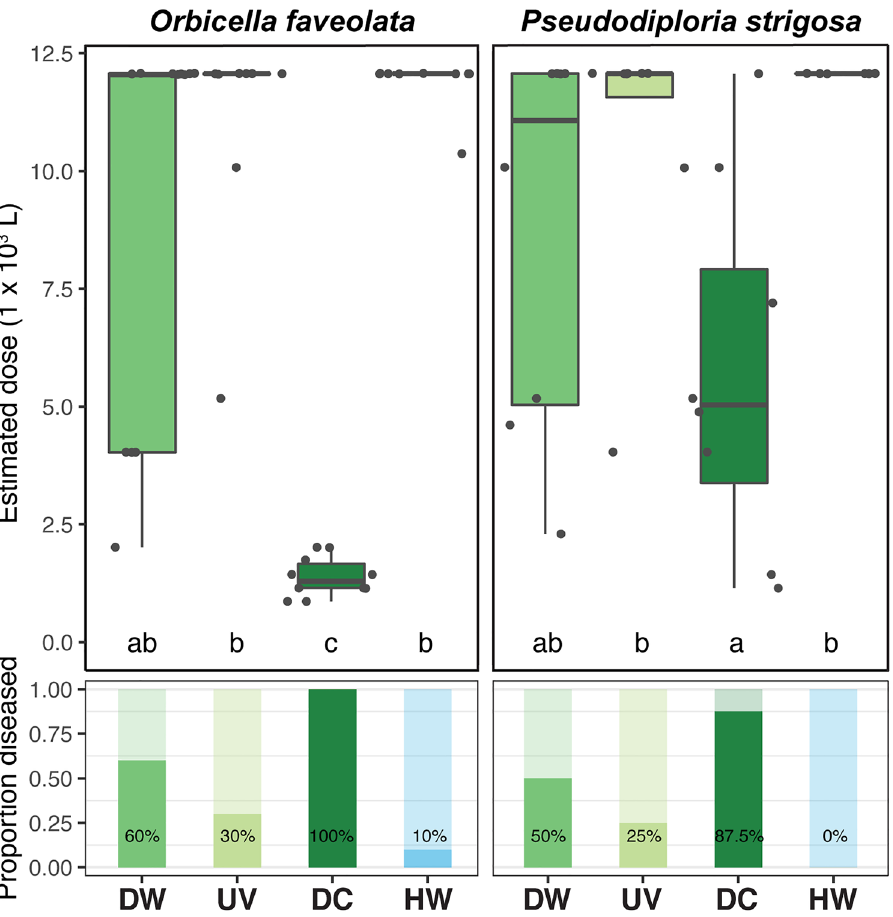
Figure 4. UV experiment transmission metrics. Estimated water dose ± SEM in liters needed to elicit SCTLD lesions (boxplots) and transmission rates (proportion of individuals exhibiting lesions). Colors denote treatments, and different letters denote significant differences among treatments. Treatment abbreviations are as follows: disease water (DW), UV-treated disease water (UV), diseased coral direct contact (DC), and healthy water